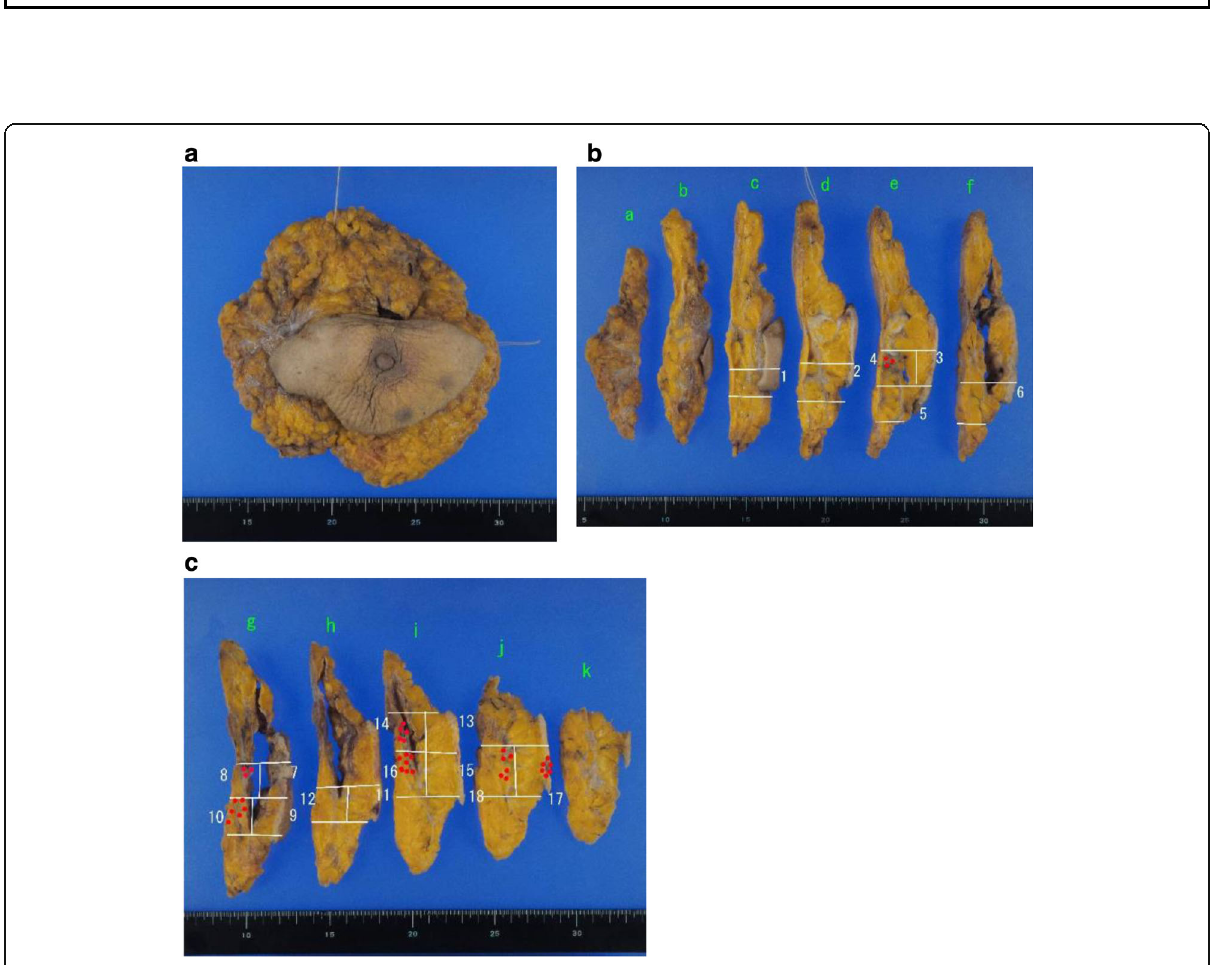
Fig. 4 The excisional biopsy yielded the diagnosis of angiosarcoma. The resection margin was positive. a The whole sample. b The cross-section of the